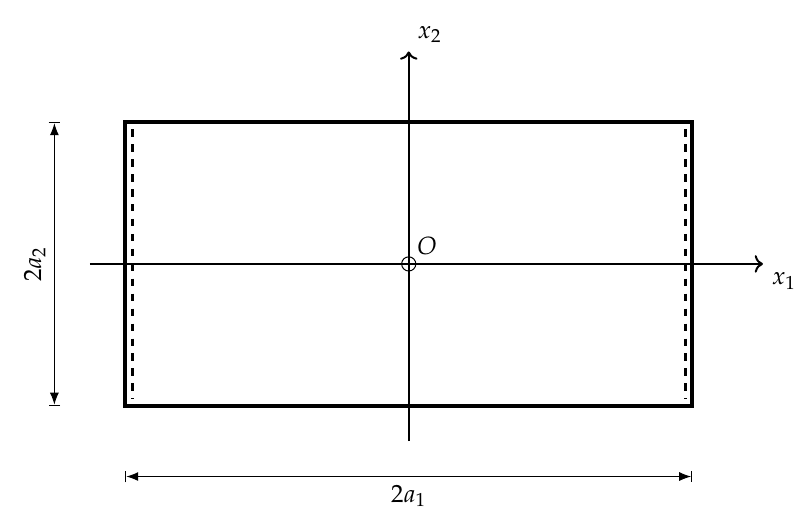
Figure 3. Rectangular plate with two opposite edges simply supported and the other free. Three-dimensional plots of deflection w and bending moments M 11 , M 22 in rectangular plate with discontinuous boundary conditions are given in Figures 4–6.